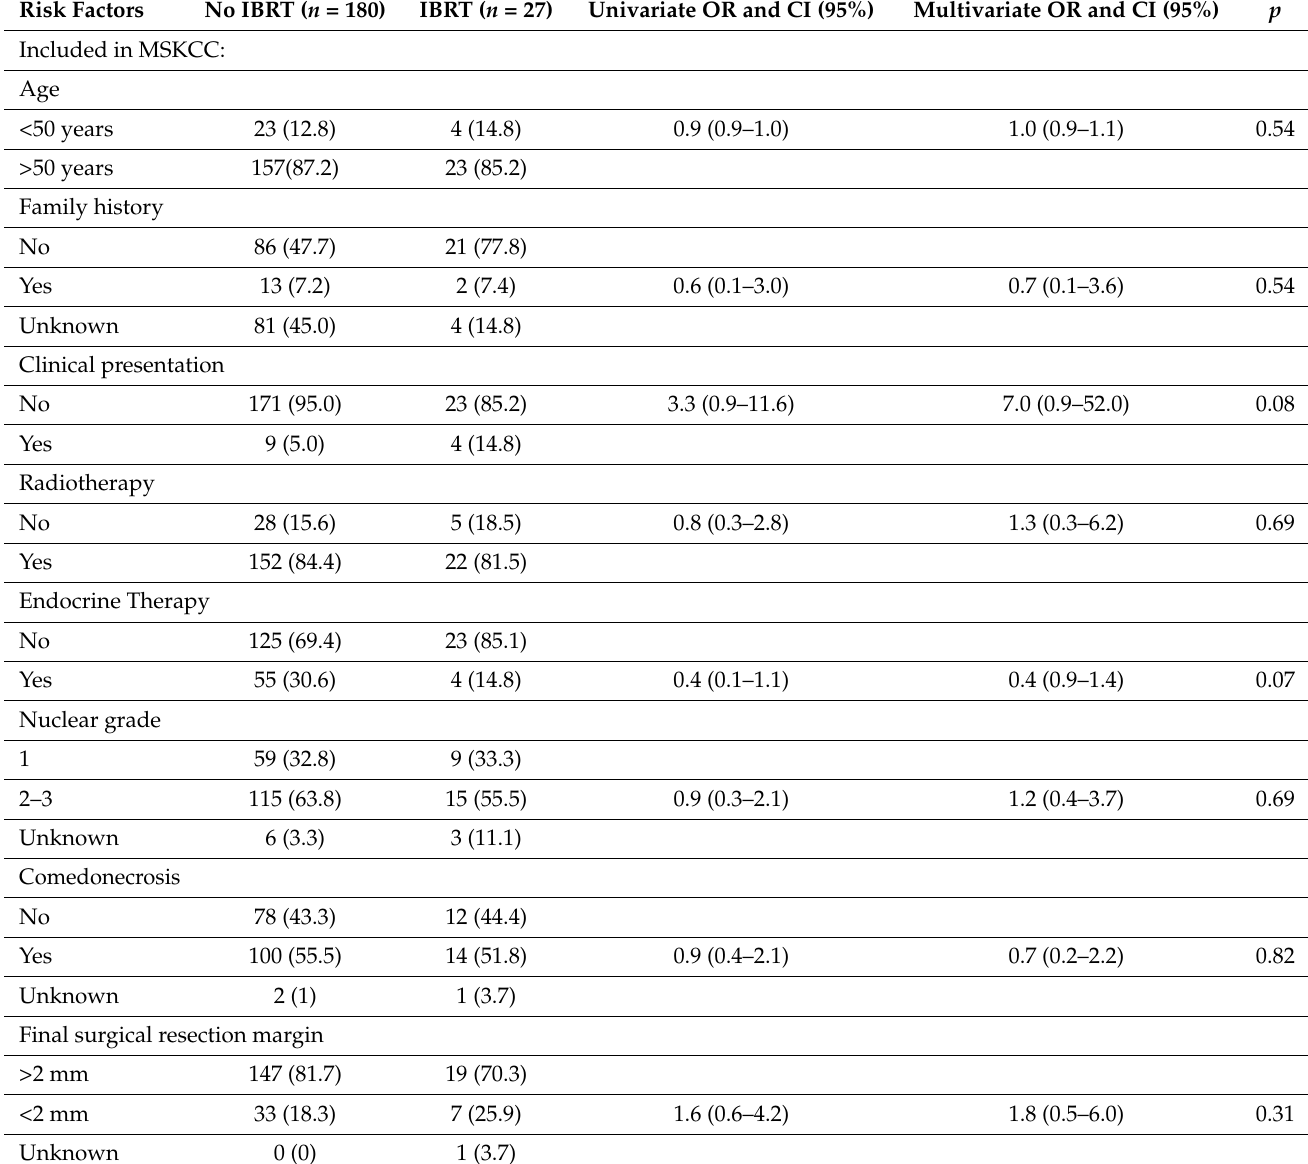
Table 2. Univariate and multivariate analysis for risk factors of